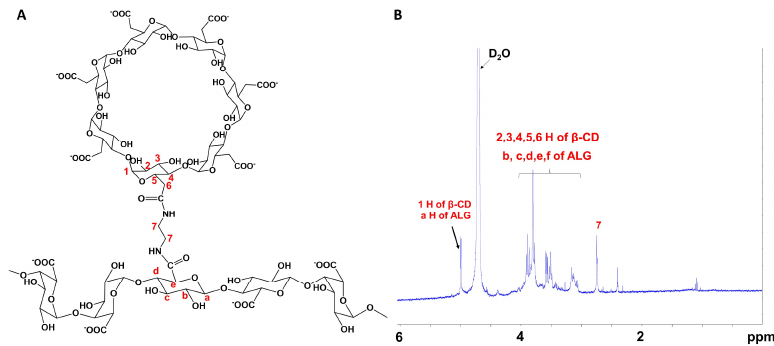
Figure 1. ( a ) β-cyclodextrin-alginate (β-CD-ALG) structure. ( b ) The proton nuclear magnetic resonance ( 1 H-NMR) spectrum of β-CD-ALG.